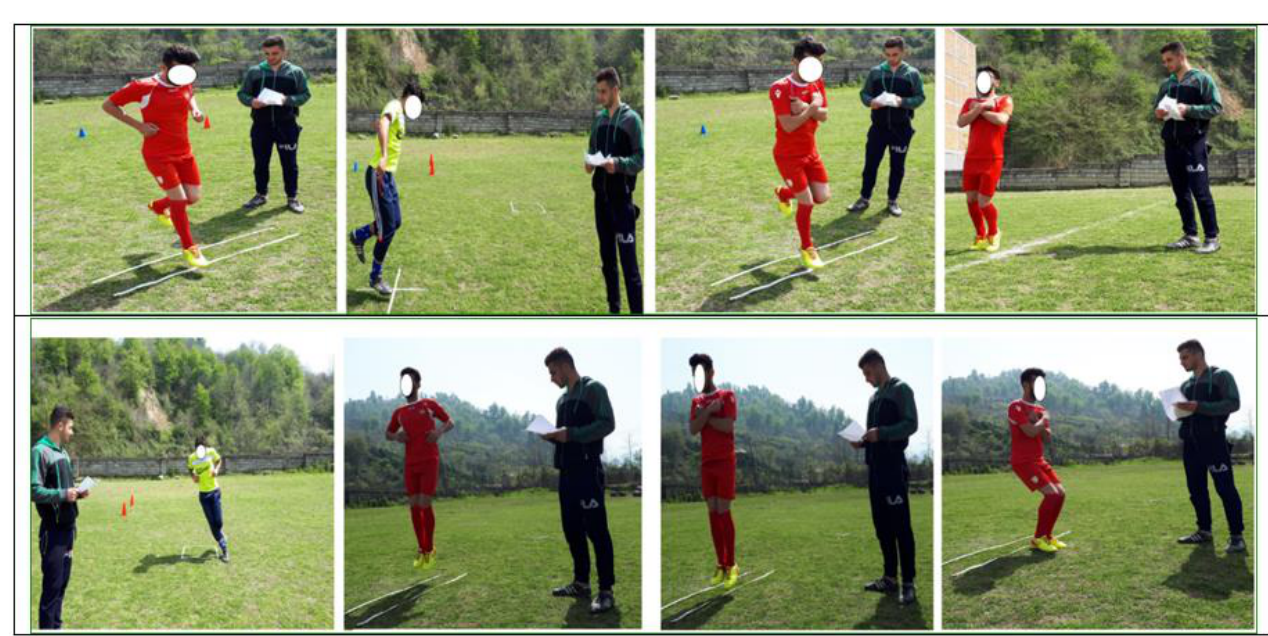
Figure 4. Examples of hopping exercises.